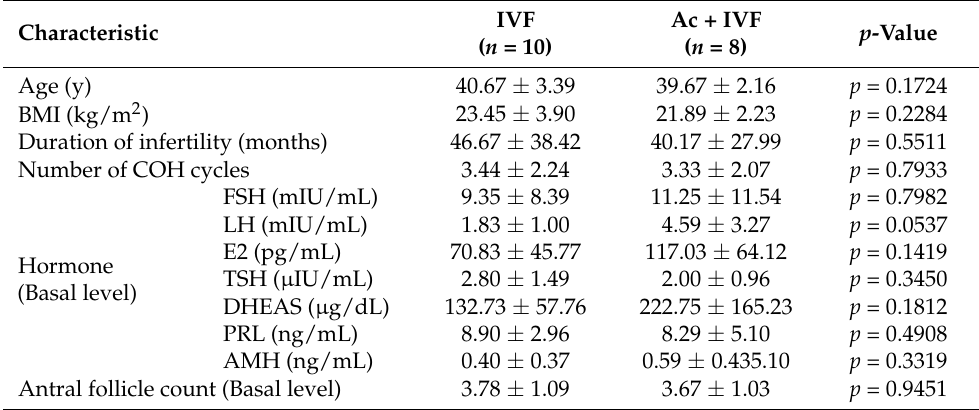
Table 5. Clinical characteristics of patients aged > 37 years enrolled in the two study groups. Characteristic